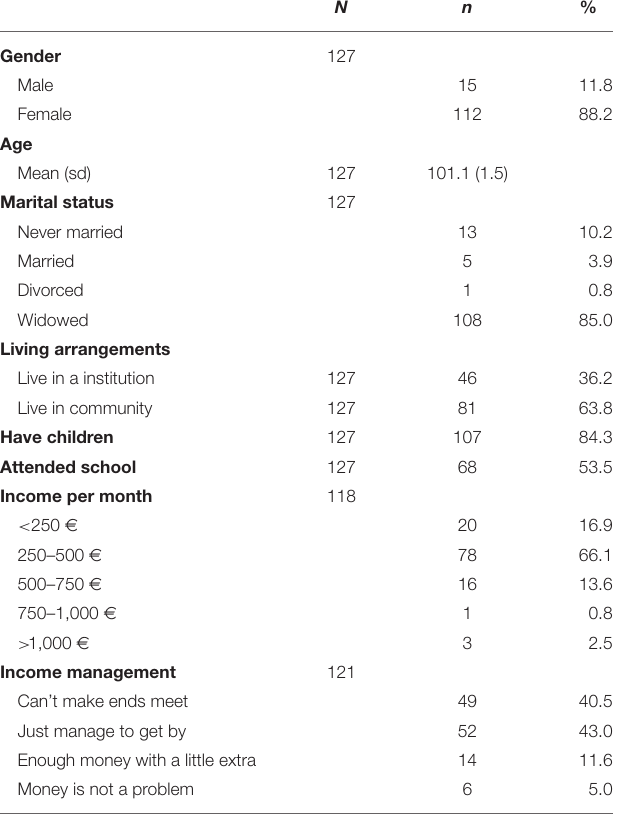
between SRH and number of diagnoses. The percentage of some agreement of the two measures was 32.3%. Only 8.7% referred a worse SRH comparing with the number of diagnoses and 59% referred a better SRH comparing with the number of